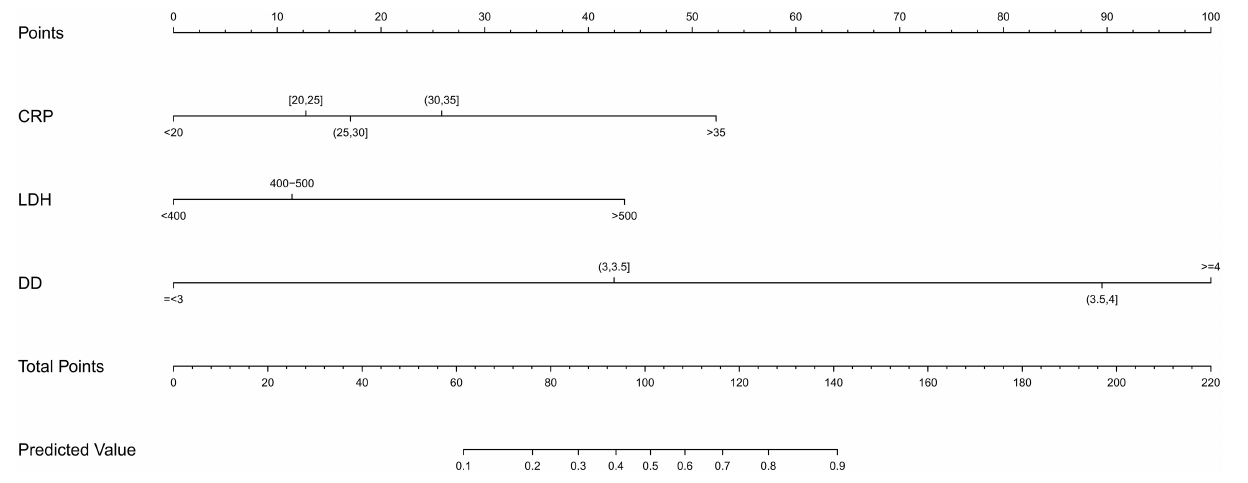
D-dimer were predictive factors for RMPP and were included in the